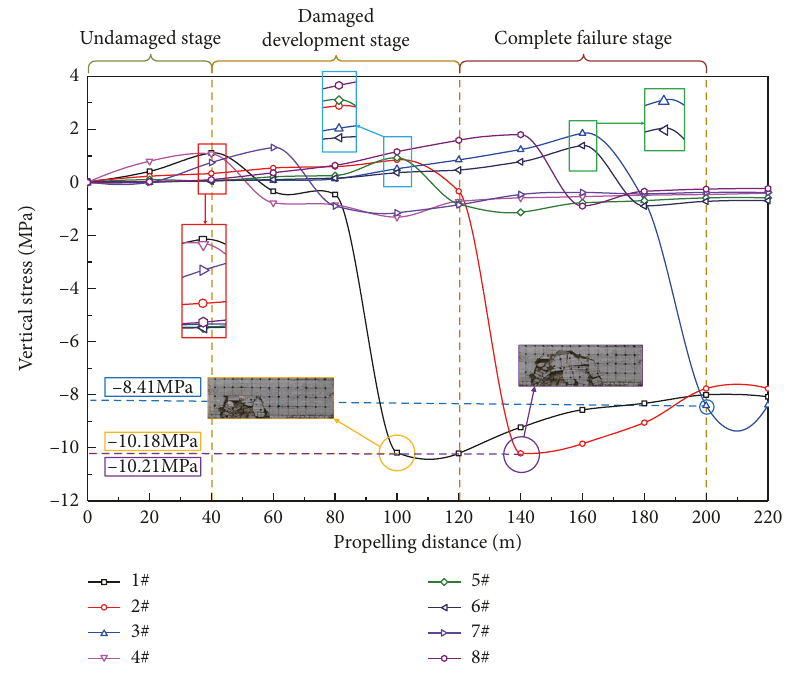
Figure 6: Stress curve of the measuring